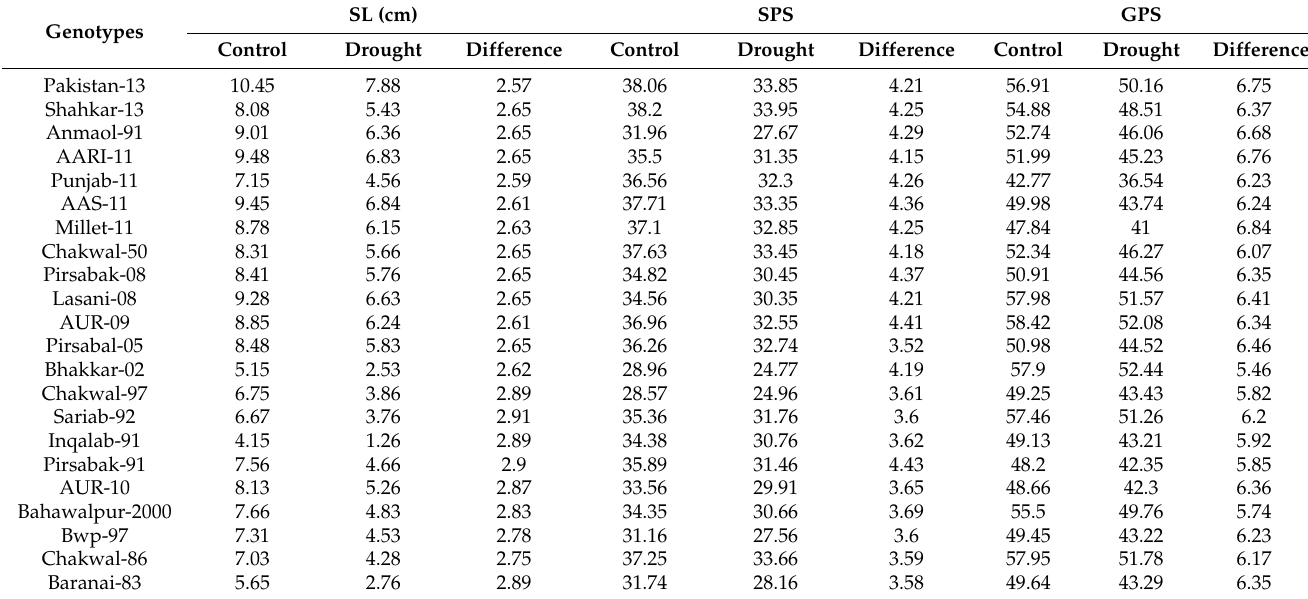
Table 3. Effect of control and water-stressed conditions on yield traits (spike length, spikelets spike − 1 , grains per spike, grain yield spike − 1 , thousand grain weight and plant biomass) of different wheat